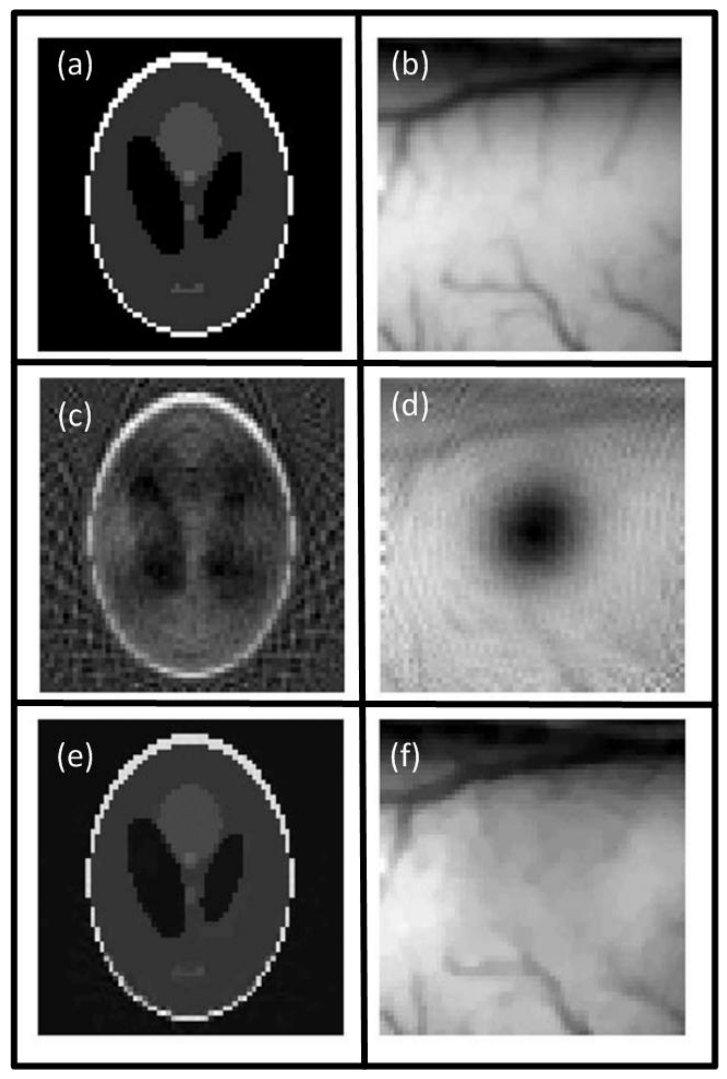
Figure 7. Reconstructions from highly undersampled data by Provost et al. [124]. The left and the right column show a Shepp-Logan phantom and a photograph of a cat brain, respectively. ( a , b ) Original images; ( c , d ) Reconstructions with pseudo-inverse of the model matrix; ( e , f ) Reconstructions using compressed sensing. Reprinted with permission from IEEE